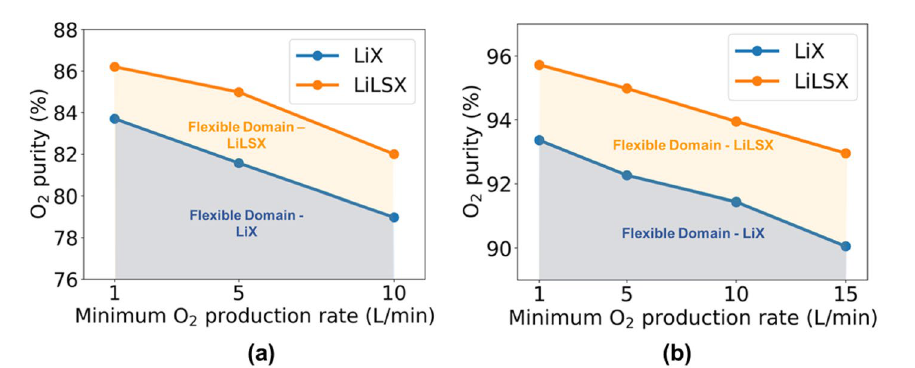
Figure 9. Purity-BSF Pareto frontier obtained using optimization-based analysis. ( a – d ) PSA with minimum production ( a ) 1, ( b ) 5, ( c ) 10 and ( d ) 15 L/min. ( e – h ) PVSA with minimum production ( e ) 1, ( f ) 5, ( g ) 10 and ( h ) 15 L/min.